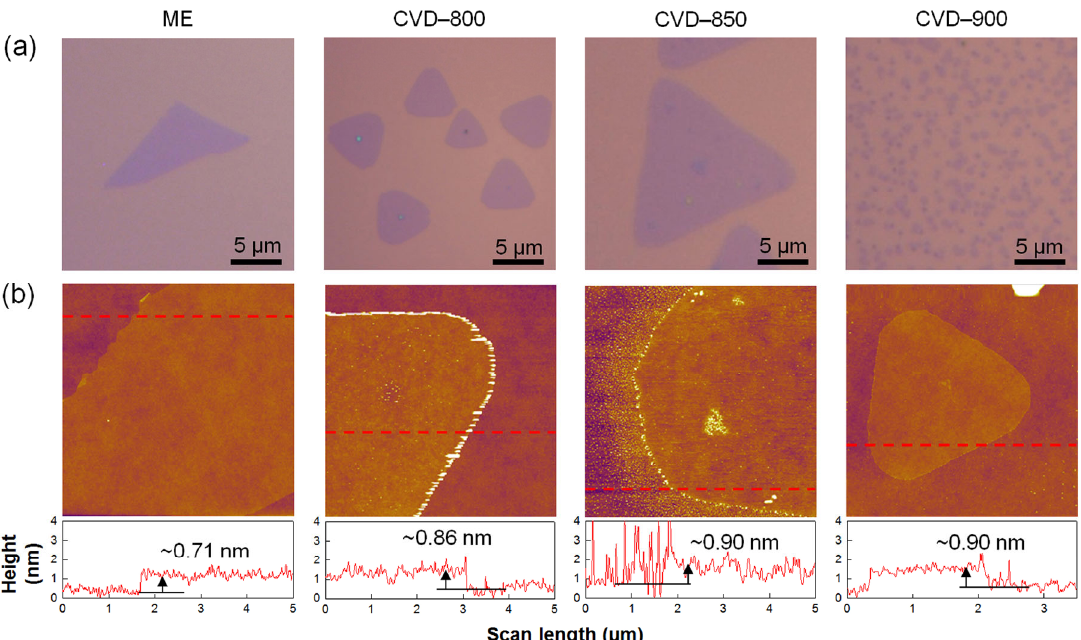
Fig. 1 (a) Optical microscopy and (b) AFM topographic images of mechanically exfoliated single-layer MoS 2 and CVD-grown single- layer MoS 2 at 800 ° C, 850 ° C, and 900 ° C. The red dashed lines indicate the locations of the cross-sectional profiles shown in